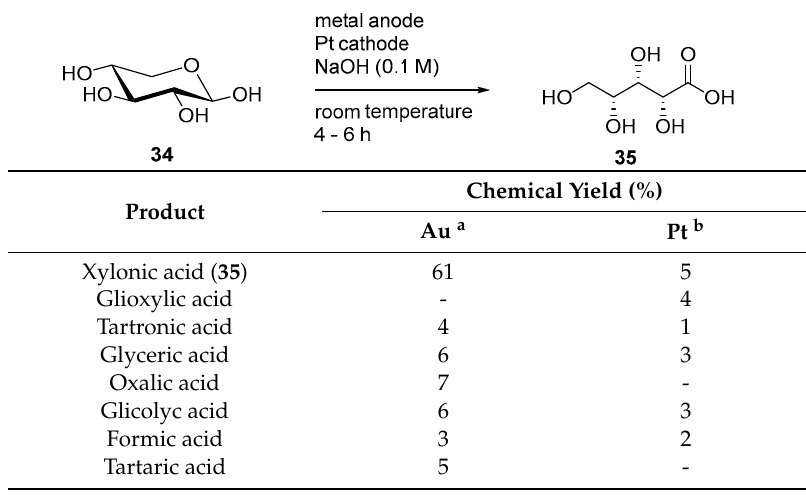
Table 5. Direct electro-oxidation of xylose at Au and Pt anodes.